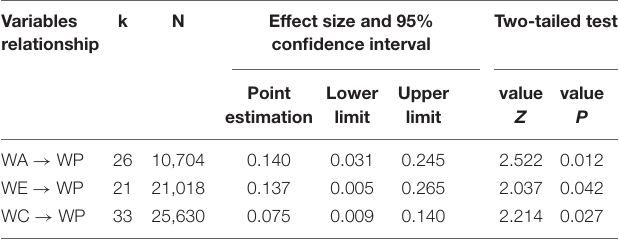
TABLE 4 | Random effect model analysis of the relationship between workaholism and work performance.